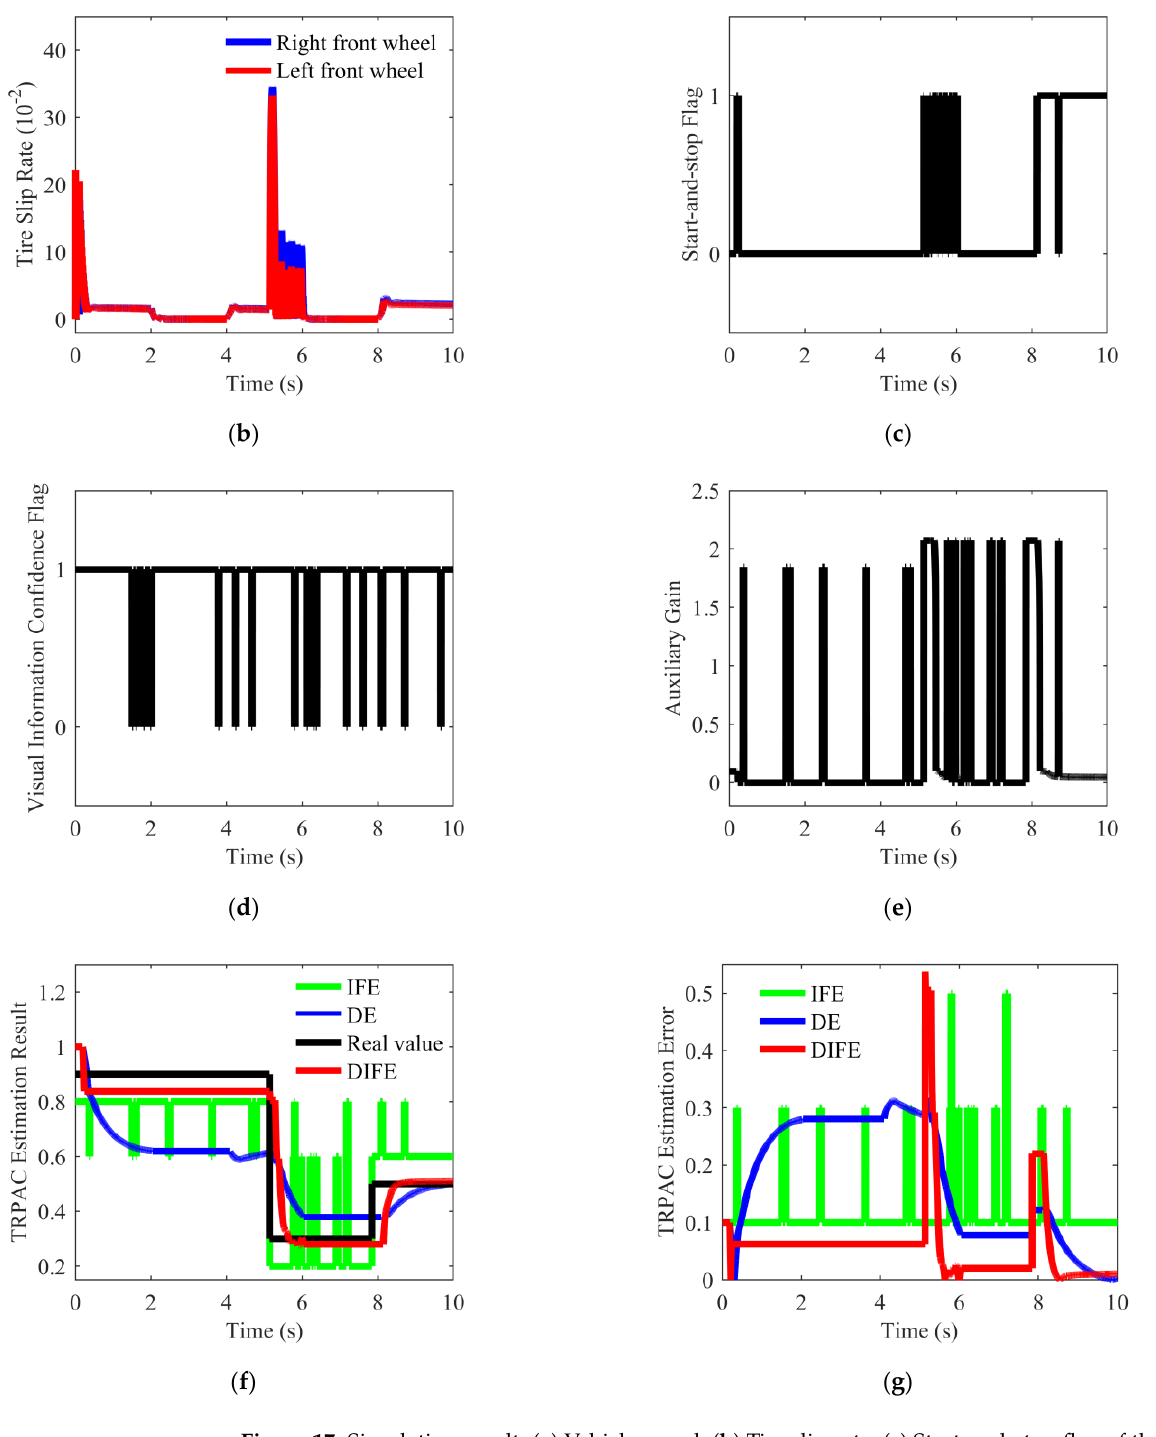
Figure 17. Simulation result. ( a ) Vehicle speed; ( b ) Tire slip rate; ( c ) Start-and-stop flag of the DIFE; ( d ) Visual information confidence flag; ( e ) Auxiliary gain of the DIFE; ( f ) Estimation result of different estimators; ( g ) Estimation error of different estimators.